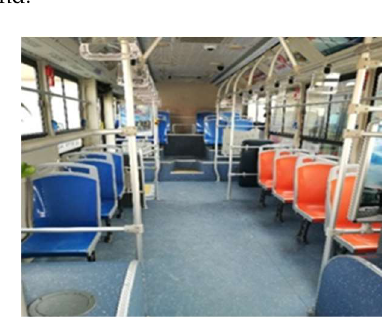
Figure 3. Skywell brand.